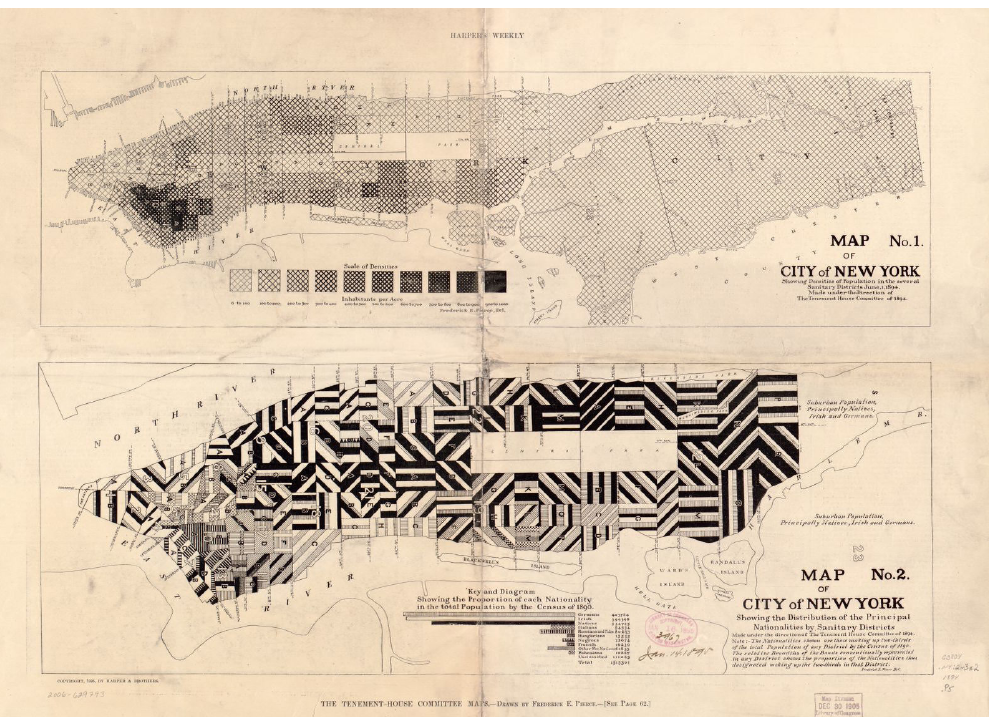
Fig. 4 Pierce, F. E. (1894)